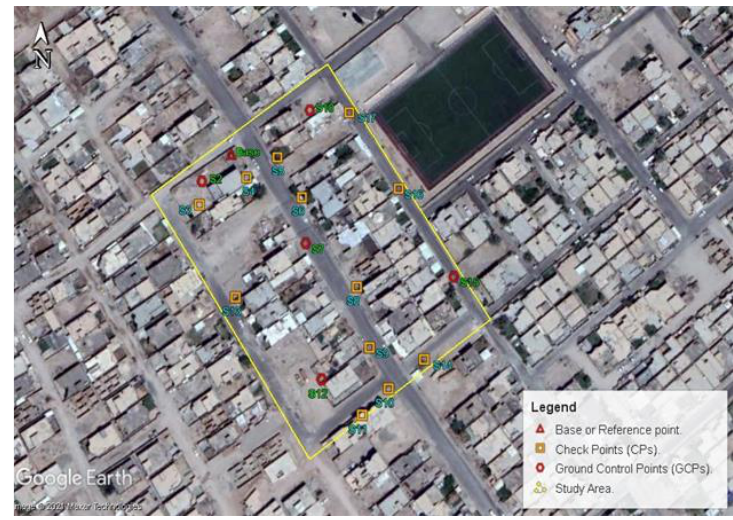
Figure 6. Distribution of ground control points and checkpoints.